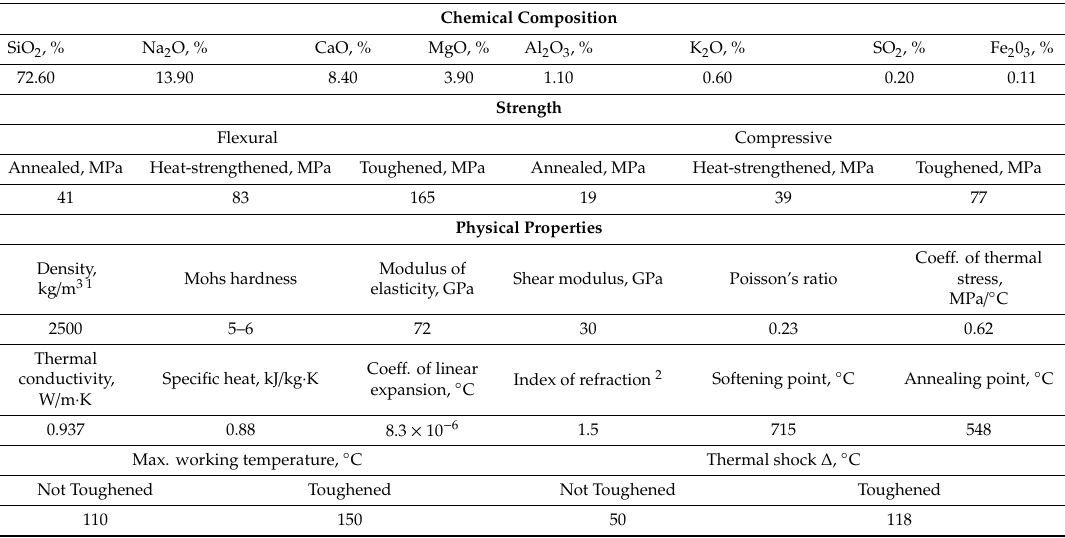
Table 2. General characteristics of soda–lime